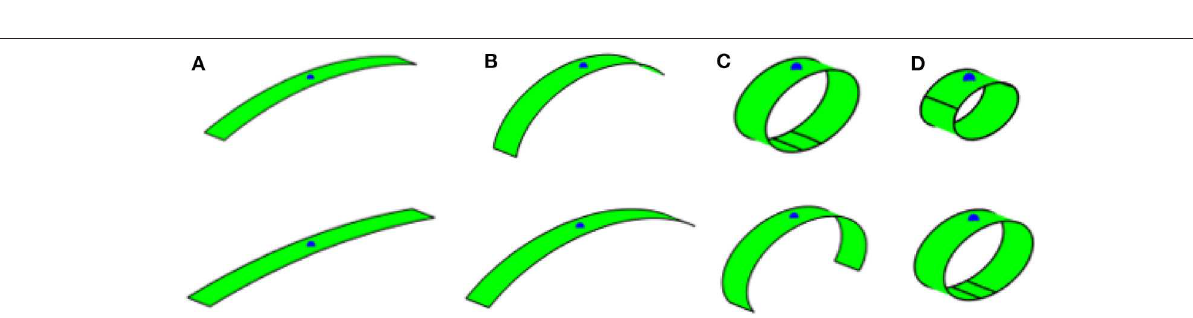
planar axis. Figure 3 illustrates the corresponding